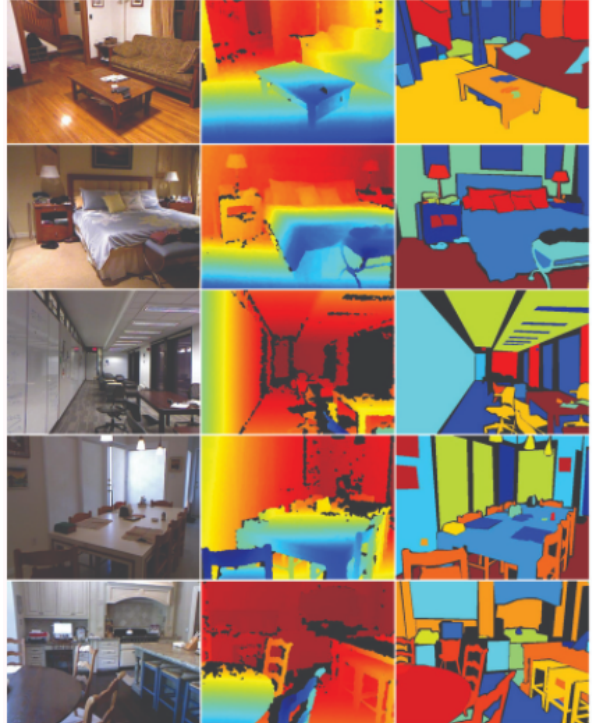
Figure 3. The NYU dataset